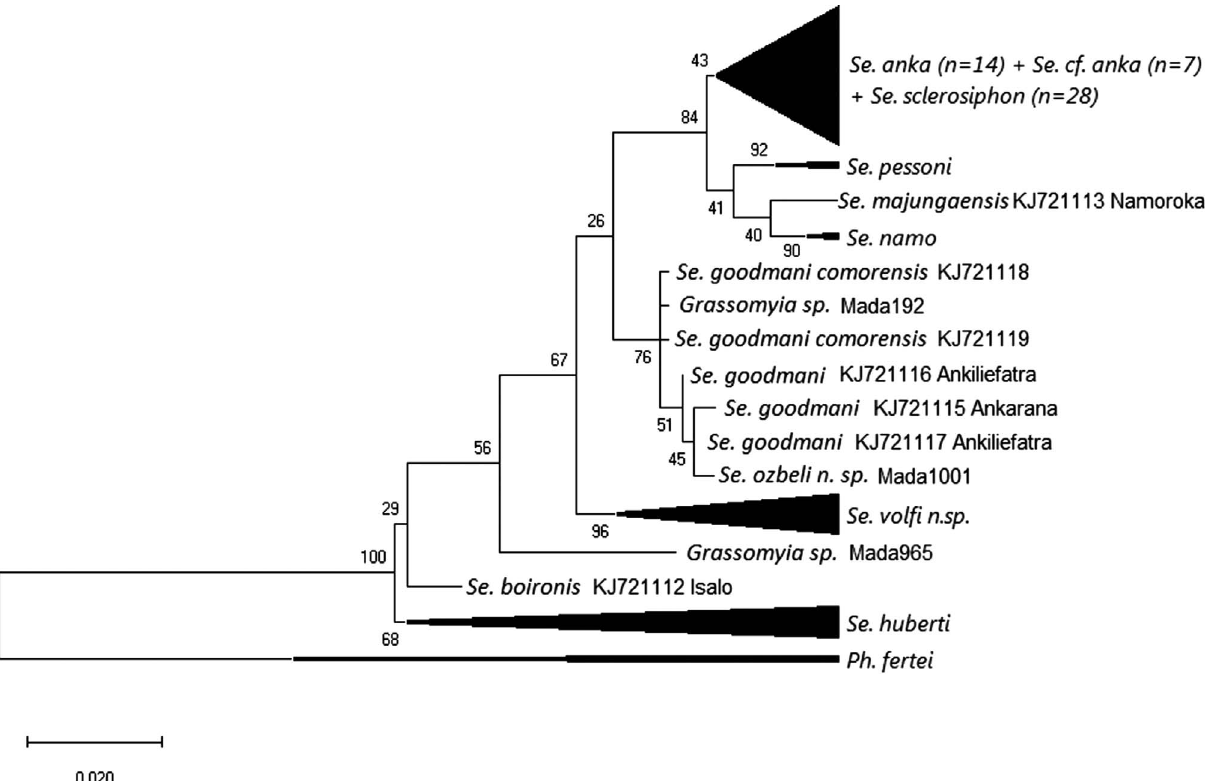
Figure 4. Maximum likelihood tree obtained from partial 28S rDNA sequences (D1 and D2 domains) based on the HKY85 model after rooting on Phlebotomus fertei . The tree with the highest log likelihood ( (cid:1) 980.66) is shown. The percentage of trees in which the associated taxa clustered together is shown next to the branches. The tree is drawn to scale, with branch lengths measured in the number of substitutions per site. The analysis involved 126 nucleotide